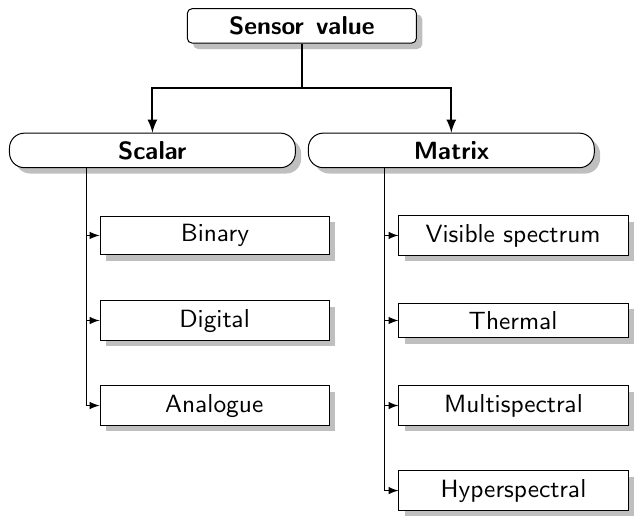
Figure 2. Taxonomy for sensor value